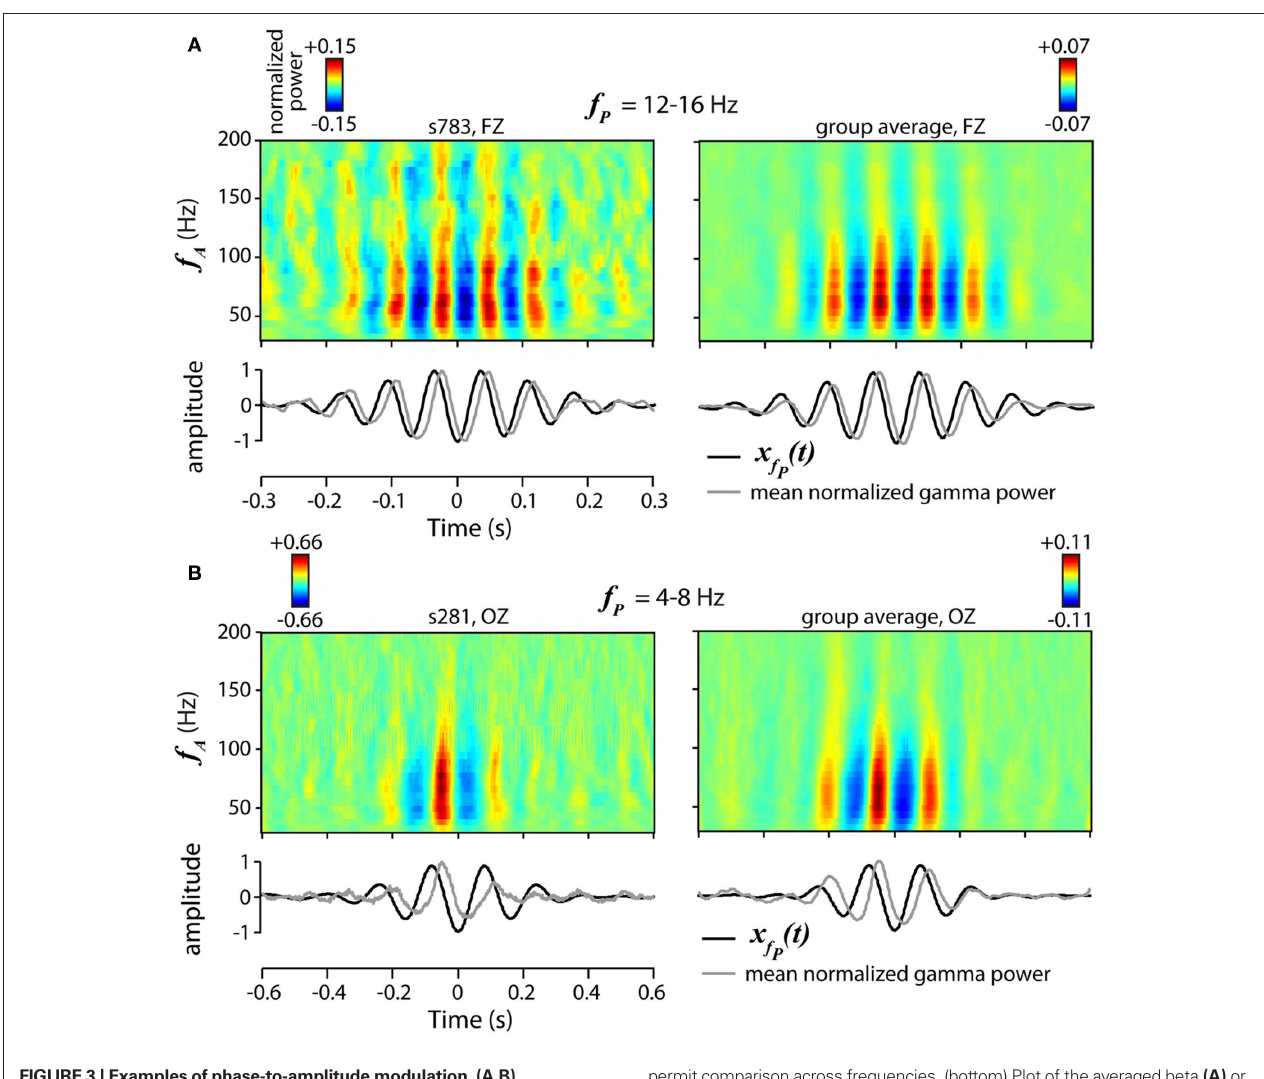
FiGuRE 3 | Examples of phase-to-amplitude modulation. (A,B) Spectrograms of mean normalized gamma power, time-locked to the beta [ f = 12–16 Hz, (A) ] or theta [ f = 4–8 Hz, (B) ] trough for a single subject (top left) P P and all subjects (top right). Spectrograms include data segments from all trials and conditions. Gamma power is normalized within narrow bands ( ∼ 6 Hz) to